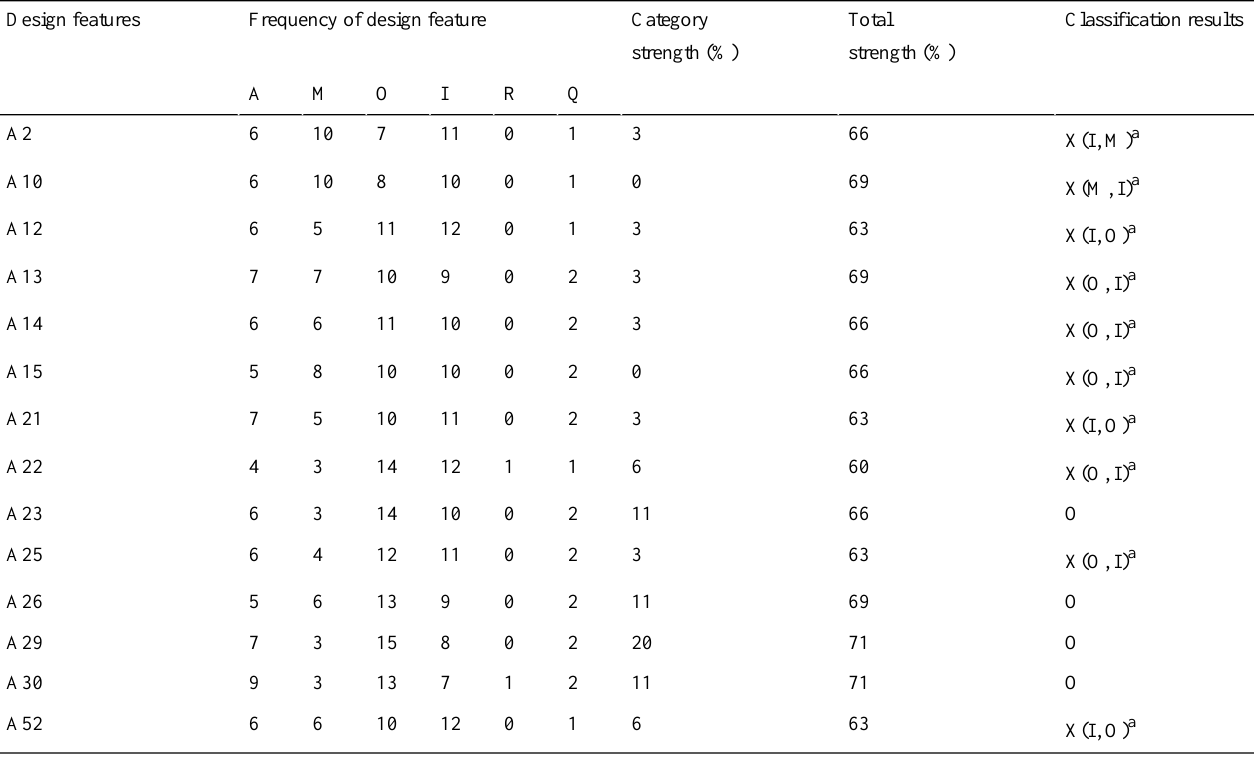
Table 8. Categorizing design features by high self-efficacy participants (n=35).